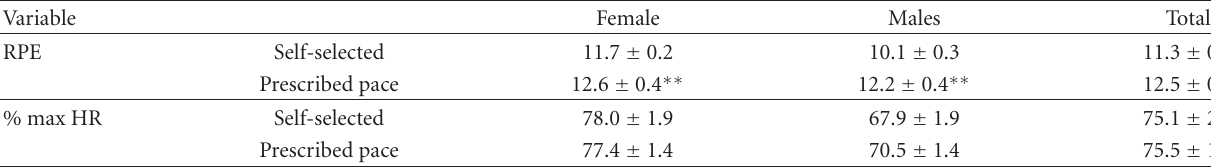
Table 2: Ratings of perceived exertion and % max heart rate for the self-selected and prescribed walking pace for both the males and females. Variable